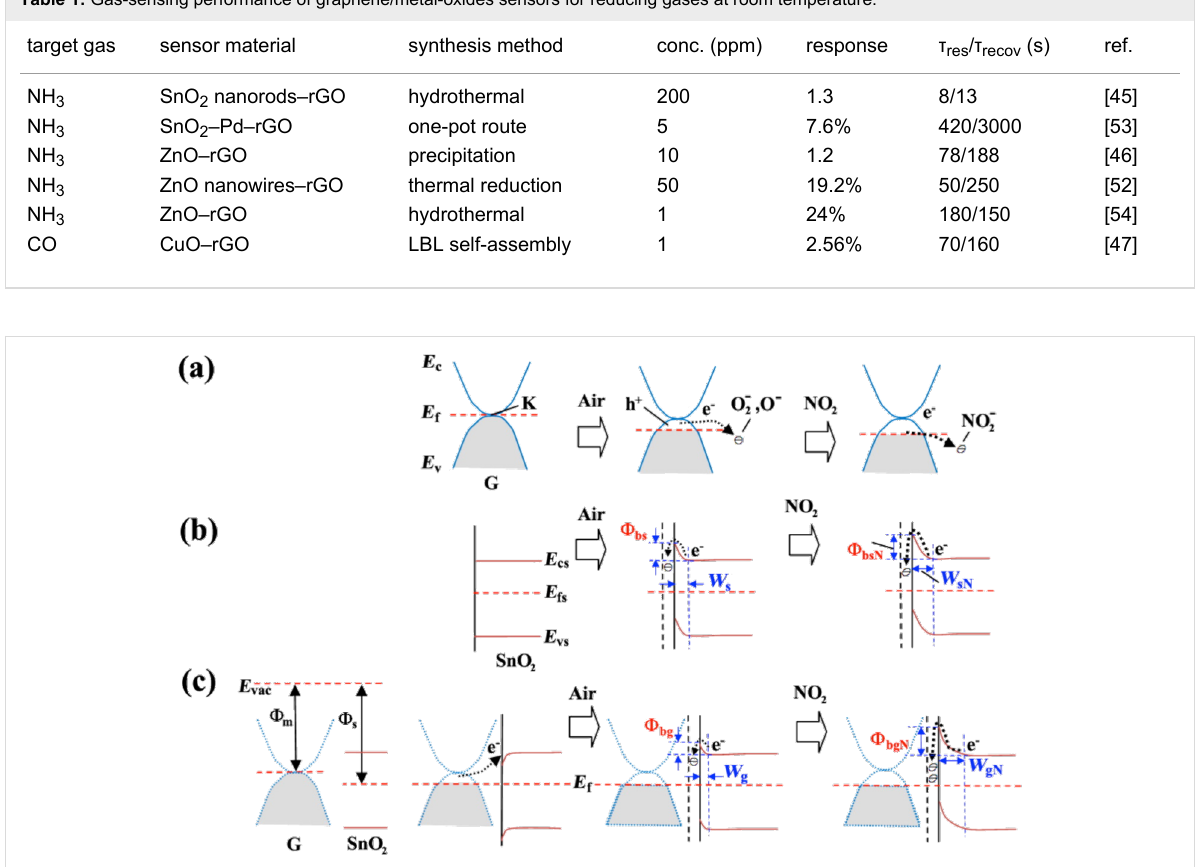
Figure 2: An illustration of the formation of p–n heterojunctions in SnO 2 –rGO hybrids. Reproduced with permission from [56], copyright 2015 Amer- ican Chemical Society.